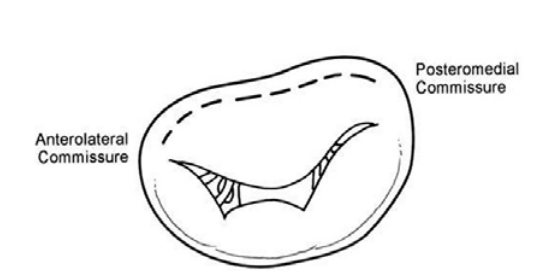
Fig. 1 - The mitral valve, dotted line is the area of incision in the anterior mitral leaflet